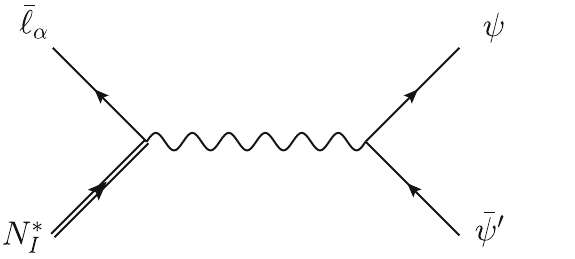
Fig. 6 Two examples for scattering diagrams involving a compos- ite heavy neutrino. They may be relevant for a full evaluation of the Boltzmann equations. Left (cid:16) L = 1 wash-out process that con-